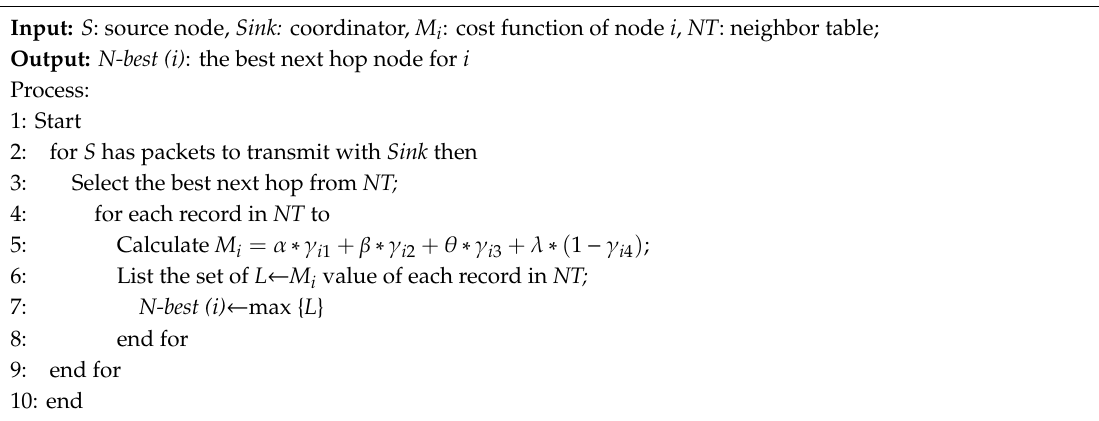
Algorithm 2: The best next hop selection procedure